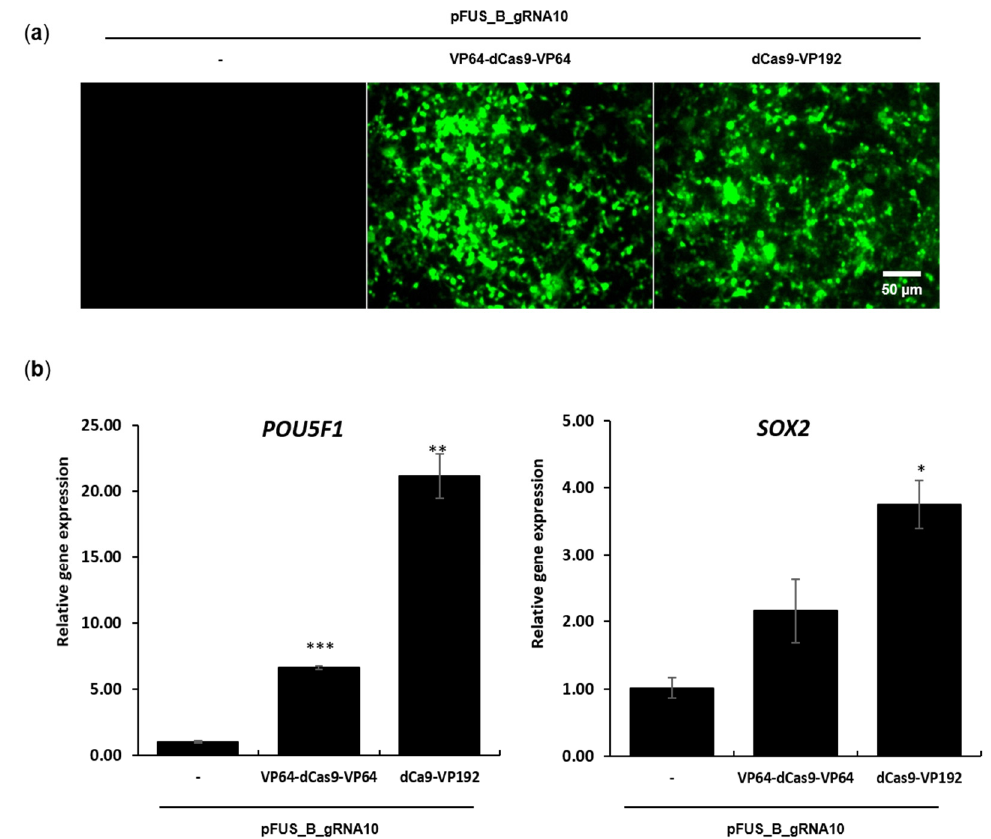
Figure 2. Activation of mRNA expression by CRISPR activators. ( a ) pFUS_B_gRNA10 was trans- fected alone and with VP64-dCas9-VP64 or dCas9-VP192 plasmid separately at the molar ratio of VP64-dCas9-VP64 or dCas9-VP192 plasmid separately at the molar ratio of 1:1 by means of Lipofectamine 3000. 1:1 by means of Lipofectamine 3000. The transfected cells were visualized under an inverted mi- croscope (OLYMPUS IX53) after 24 h of transfection. Only the pFUS_B_gRNA10 transfected cells served as a negative control. ( b ) After 72 h of transfection, total RNA was isolated and proceeded for a gene expression analysis of POU5F1 and SOX2 via the SYBR Green detection method. Cyclo- philinG gene served as an endogenous control, while the control represents only pFUS_B_gRNA10 transfected cells. The primers specific to each gene are enlisted in Table S2. The represented values are the average of three independent experiments, where bars represent ± SEM